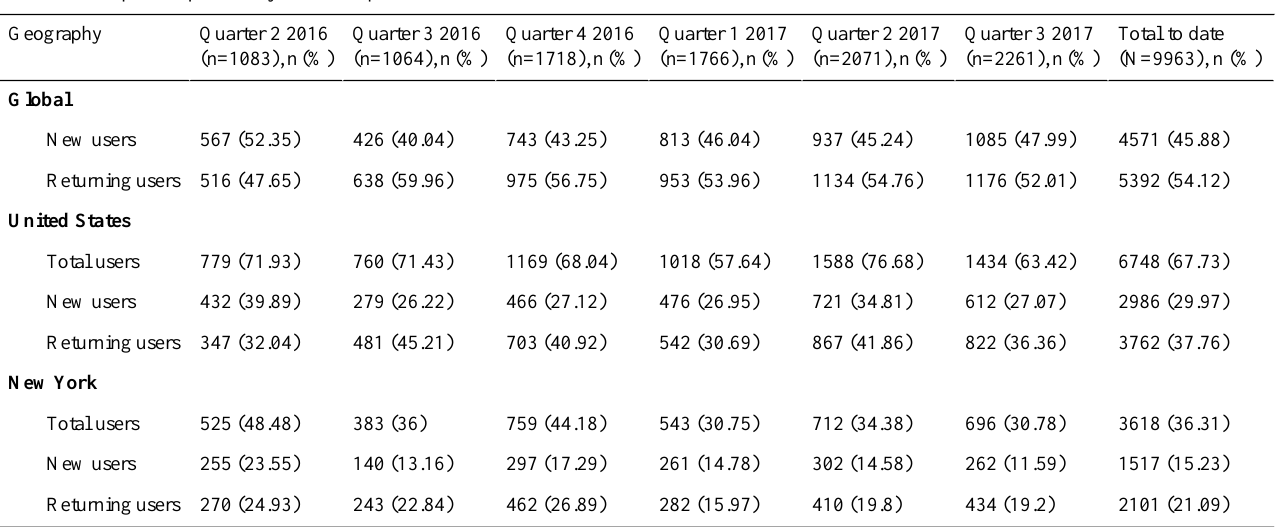
Table 1. Completed episodes by calendar